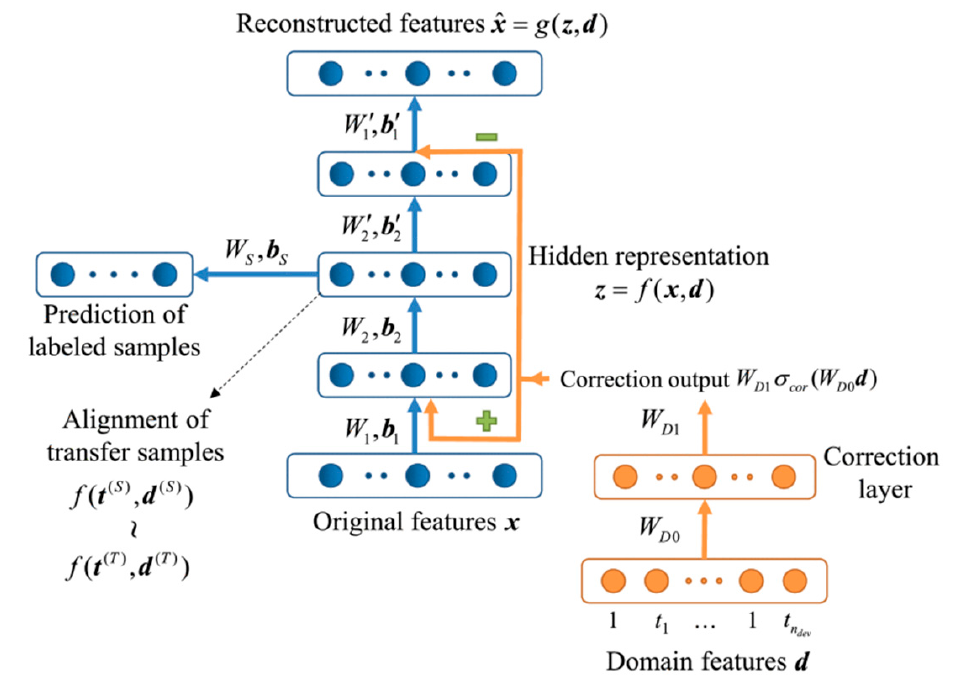
Figure 13. DCAE with correction layer and hidden layers [34].